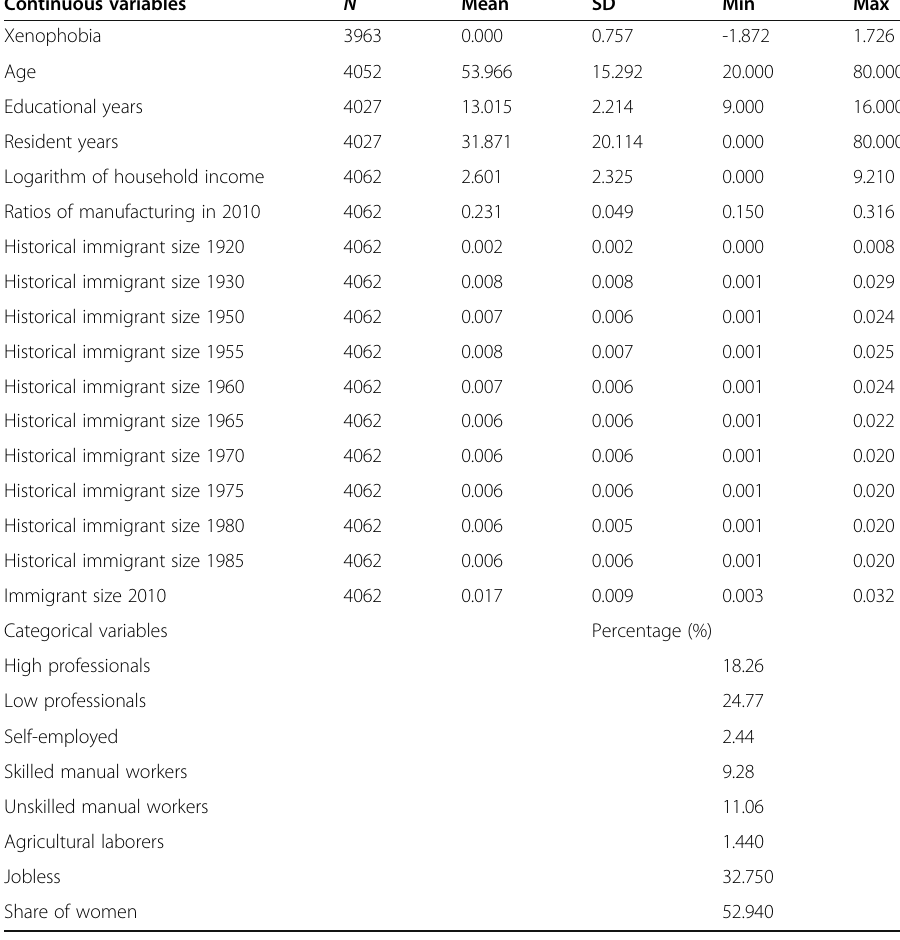
Table 3 Description of